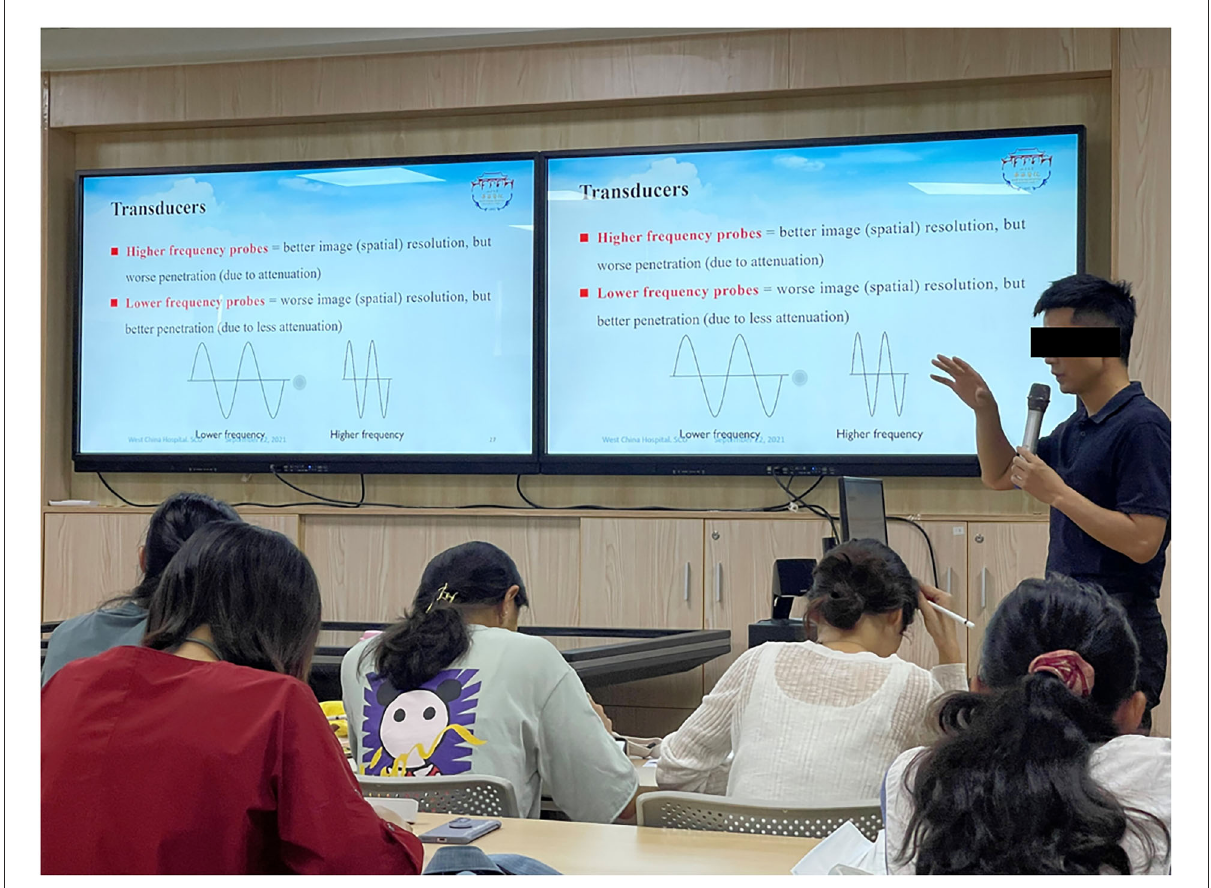
FIGURE2 Domestic on-site teaching mode, this mode was carried out by a Chinese teacher in